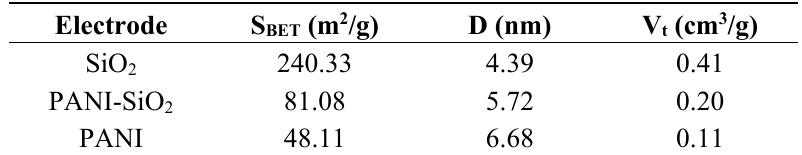
Figure 5. ( A ) N 2 adsorption/desorption isotherms of mesoporous silica, PANI-silica and bulk PANI. ( B ) Pore size distribution curves of mesoporous silica, PANI-silica and bulk PANI. Table 1. N 2 adsorption/desorption measurement results of bulk PANI, mesoporous silica and